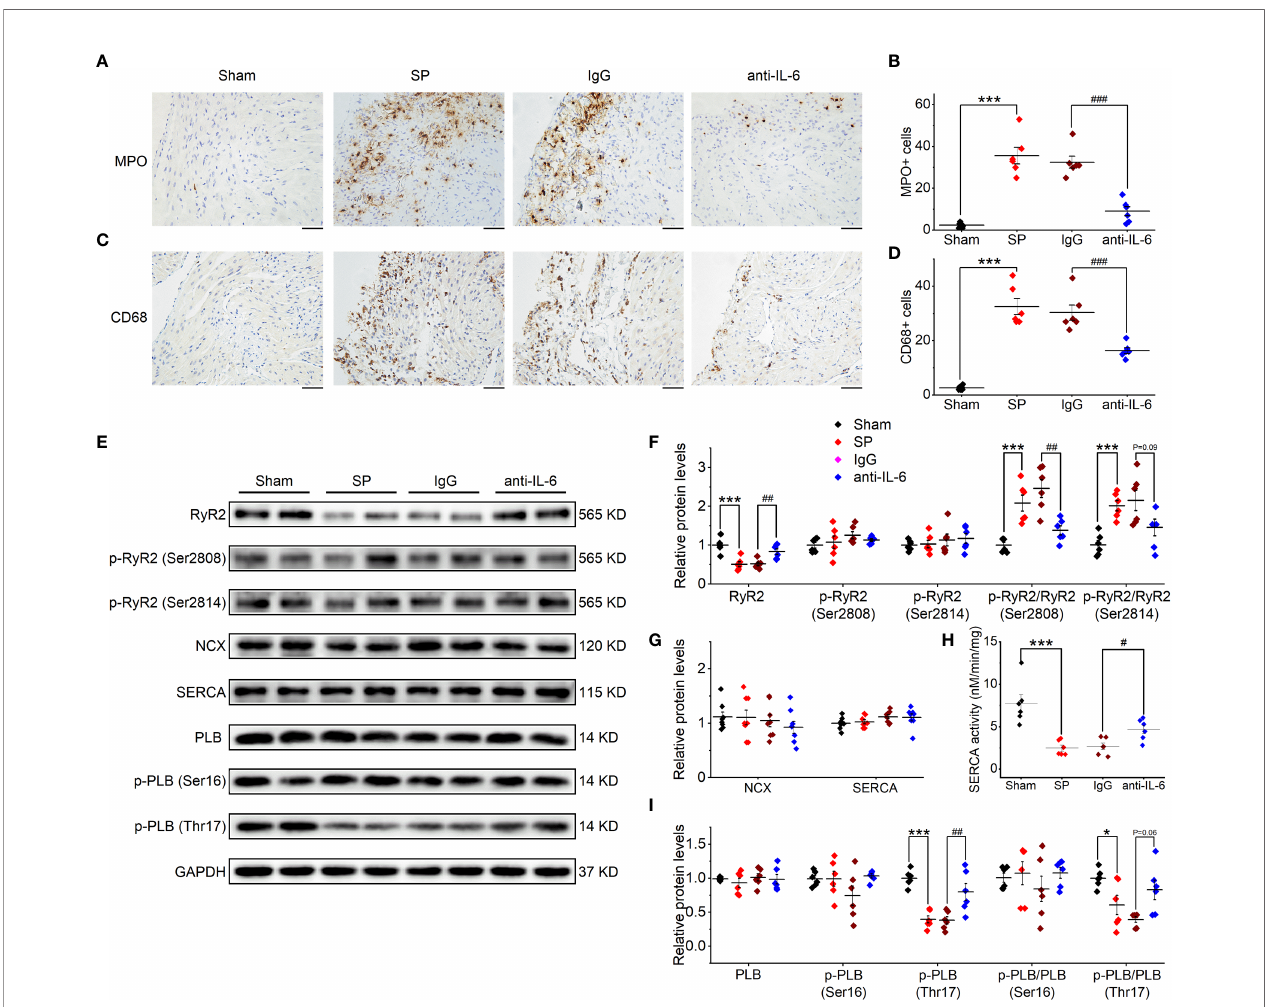
FIGURE 2 | IL-6 neutralization prevents atrial in fl ammation and the alterations in Ca 2+ handling proteins in SP rats. (A, B) Representative images of atrial MPO staining (A) and quanti fi cation (B) in the 4 indicated groups. Five visual fi elds are taken in each sample, and the number of immune cells from these fi elds is quanti fi ed with ImagePro 6.0 software and is averaged to make a statistical analysis. n = 6-7/group. Scale bar: 50 µm. (C, D) Representative images of atrial CD68 staining (C) and quanti fi cation (D) . n = 6-7/group. Scale bar: 50 µm. (E – I) Original Western blot (E) and quanti fi cation of the expression of RyR2, p-RyR2 (Ser2808), p-RyR2 (Ser2814) (F) , the expression of SERCA and NCX (G) , SERCA activity (H) , the expression of PLB, p-PLB (Ser16), and p-PLB (Thr17) (I) , in atrial tissue of 4 indicated groups. n =6-8/group. *P < 0.05, ***P < 0.001 vs . Sham; # P < 0.05, ## P < 0.01, ### P < 0.001 vs . IgG, determined by Student t-test or one-way ANOVA with Bonferroni ’ s post-hoc test. (F – H)